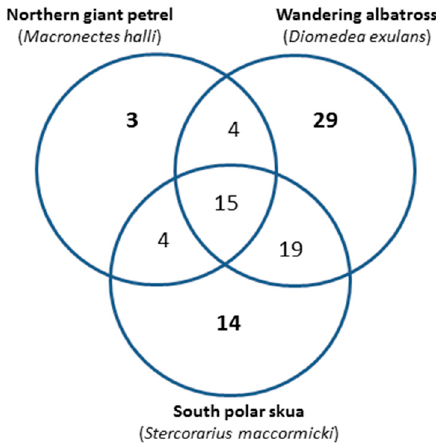
Figure 4. Venn diagram of deiminated protein hits identified in seabird plasma by liquid chromatography with tandem mass spectrometry (LC–MS/MS). The identity of deiminated proteins isolated by F95 enrichment from plasma of wandering albatross ( Diomedea exulans ), northern giant petrel ( Macronectes halli ) and south polar skua ( Stercorarius maccormicki ) was assessed by LC–MS/MS analysis. Some differences in deiminated protein hits were identified, with 3, 29 and 14 unique hits for northern giant petrel, wandering albatross and south polar skua, respectively. Overall, 15 protein hits were identified as common deimination candidates in all three seabird species tested.